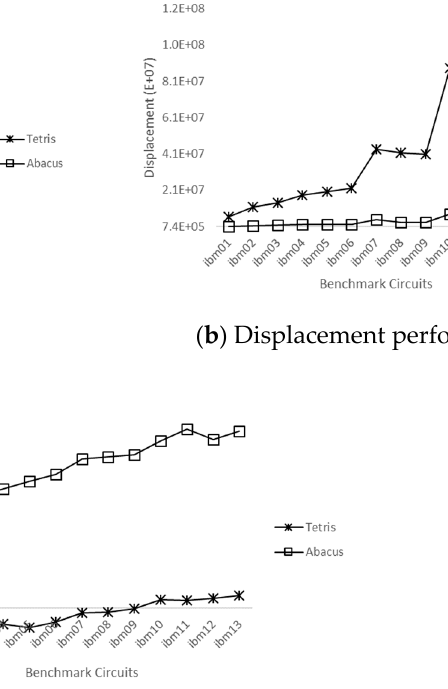
Figure 4. Performance comparison standalone Tetris and Abacus. HPWL—half perimeter wirelength.